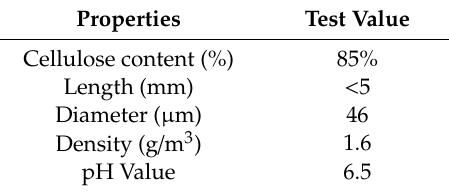
Table 3. Properties of cellulose